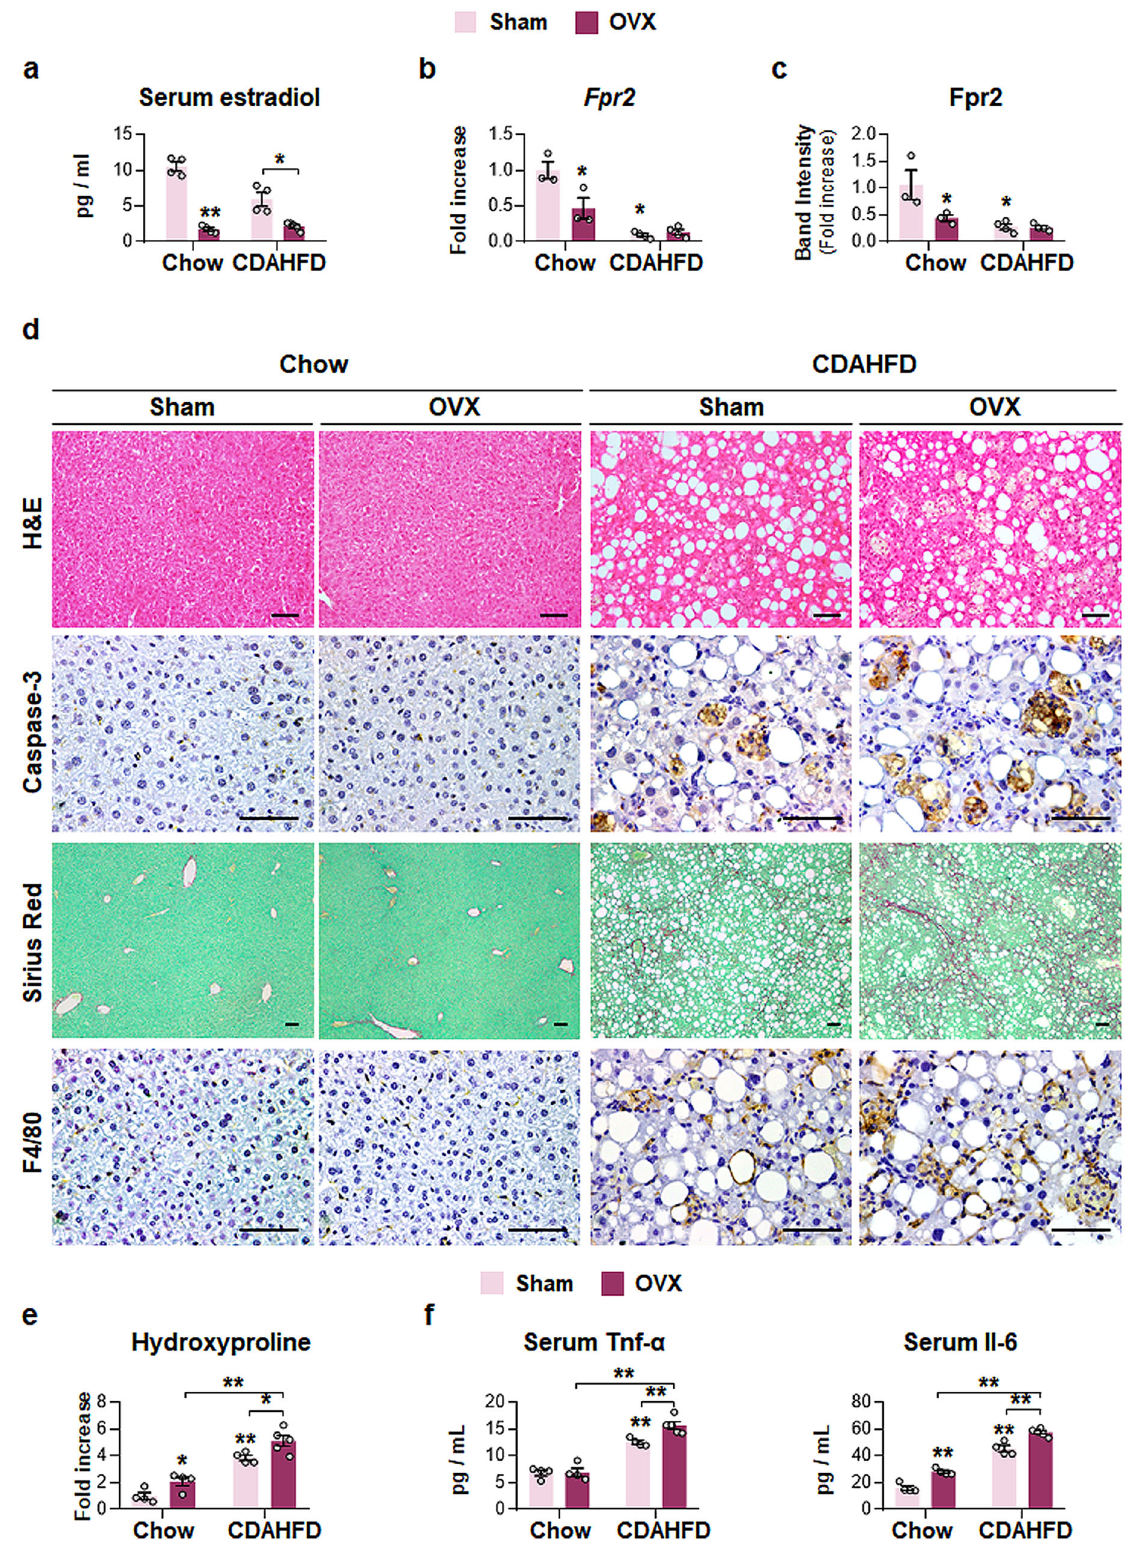
Fig. 10 Ovariectomy decrease hepatic Fpr2 level, and increases liver injury in female mice fed CDAHFD. a Level of serum estradiol in, b qRT-PCR and c cumulative densitometric analysis for hepatic Fpr2 in sham (Sham) or ovariectomized (OVX) female mice treated with either chow or CDAHFD for 12 weeks. Band densities were normalized to the expression level of Gapdh, an internal control. Data represent the mean ± S.E.M. ( n ≥ 3/group, * p < 0.05, ** p < 0.005 vs Chow-Sham). d Representative images of H&E-, Caspase-3-, Sirius red-, and F4/80-stained liver sections from these mice (Scale bar: 50 μ m). e Hepatic hydroxyproline content and f serum Tnf- α and Il-6 level in these mice. Data represent the mean ± S.E.M. ( n ≥ 3/group, * p < 0.05, ** p < 0.005 vs Chow-Sham). Gray circles represent individual data points. See Supplementary Data for statistical